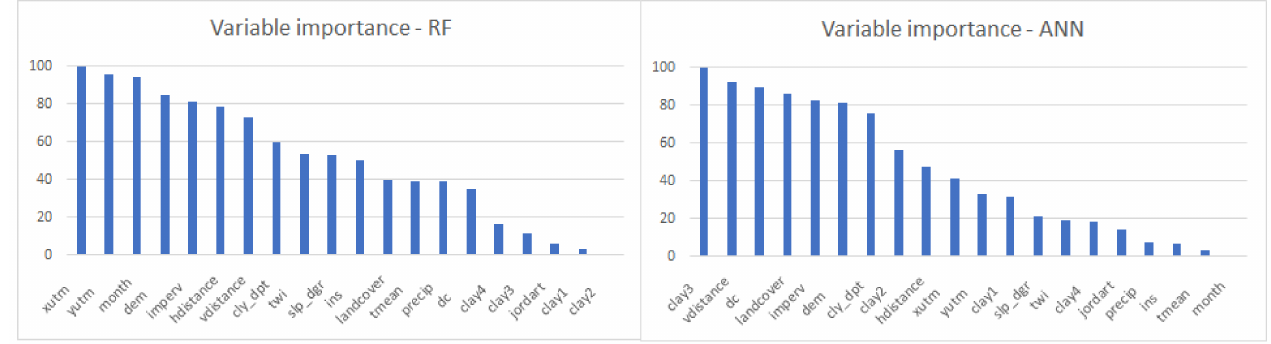
Figure 4. Importance of the variables based on the RF ( left ) and the ANN ( right ) models.